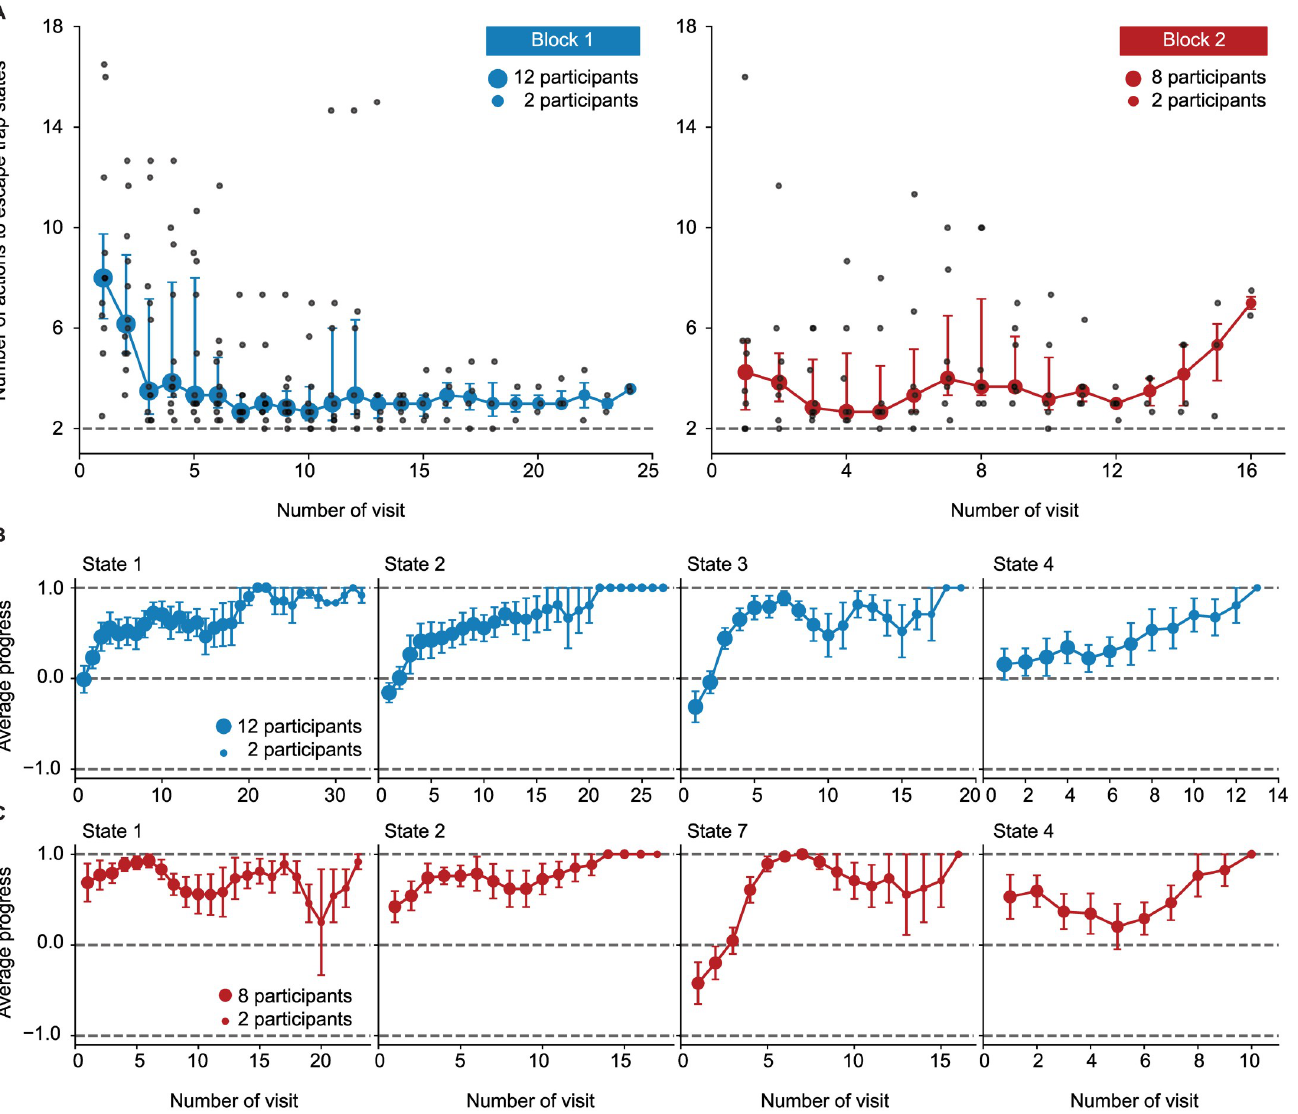
Fig 2. Behavioral results for episode 1 of blocks 1 and 2. A . Escape from the trap states: Median number of actions of participants between falling into a trap state and reaching state 2 in episode 1 of block 1 (left) and block 2 (right). Error bars show the 25% and 75% quantiles, and each grey point shows the data of one participant. The grey dashed lines correspond to the minimum number of actions (2) that are needed to escape the trap states. x-axis shows the number of visits of the trap states, for example, 10 means the 10th times participants fall from a progressing state into the trap states. Because of between-participant differences, not all participants visited the trap states for, e.g., 20 times. The size of circles indicates number of participants over which the average is taken. In the 1st episode of block 2 (right), four participants reached the goal state without falling into the trap states; thus, only the data for the other 8 participants is shown. A moving average of length three was applied to the data. B . Average progress of participants each time visiting states 1, 2, 3, and 4 in episode 1 of block 1. We assign a progress value of 1 to good actions (the ones taking participants closer to the goal), 0.5 to neutral actions (the ones making participants stay where they are), and -0.75 to bad actions (the ones taking participants to the trap states); with this assignment, average progress vanishes for random exploration. The size of circles shows the number of participants over which the average is taken, and error bars show the standard error of the mean. A moving average of length three was applied to the data. C . Average progress of participants each time visiting states 1, 2, 7 (swapped with 3), and 4 in episode 1 of block 2. See S1 Fig (A) for the average progress at the progressing states in the proximity of the